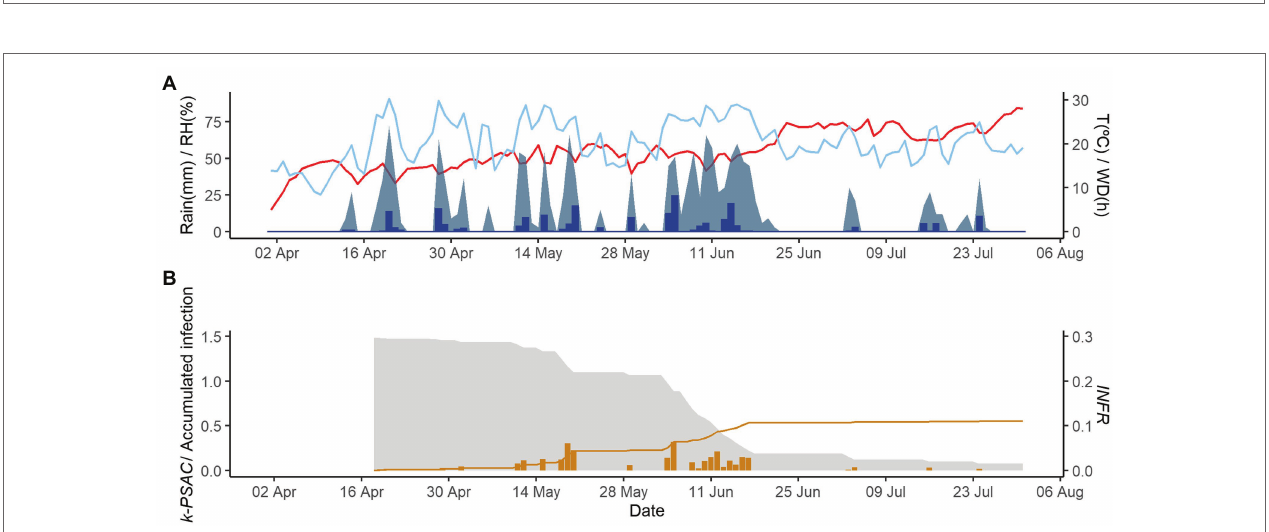
FIGURE 2 | Model output for the vineyard in Piacenza in 2020. (A) Weather data: air temperature (T, red line in ° C), rain (blue bars in millimeters), wetness duration (WD, light blue area in hours), and relative humidity (RH, blue line in %). (B) The gray is represent the inoculum dose as k - MATR (gray area), daily values of predicted infection (orange bars; average value of INFR L and INFR S ), and accumulated infection during the season (orange line).